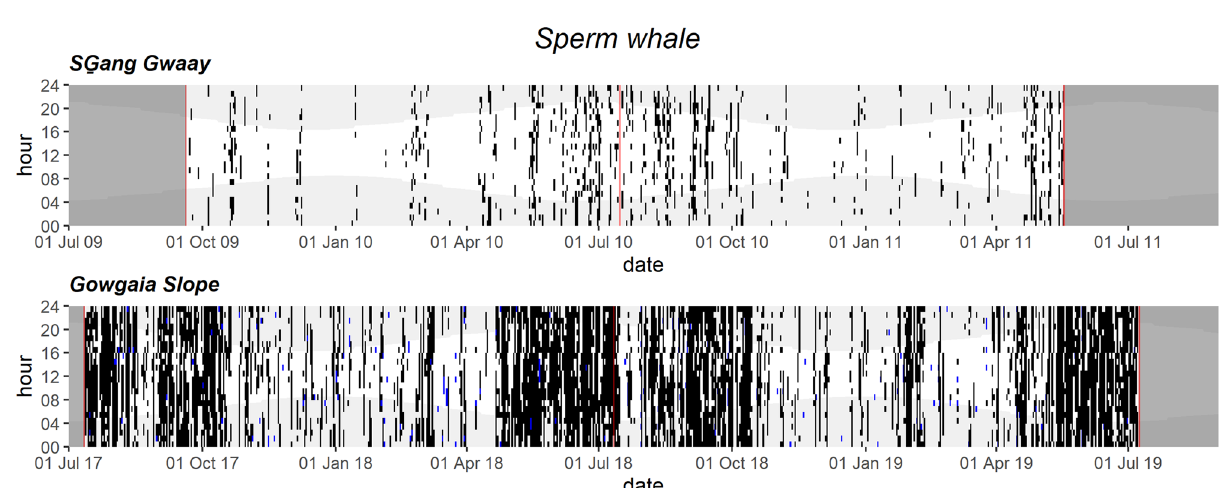
Figure 8. Daily and hourly occurrence of sperm whale vocalizations at SG ̱ ang Gwaay and Gowgaia Slope in 1-h bins. Blue dots indicate automated detections. Black dots indicate confirmed occurrence. Red lines indicate recorder deployment and retrieval dates. Dark grey areas indicate a lack of recordings. Light grey shaded areas indicate hours of